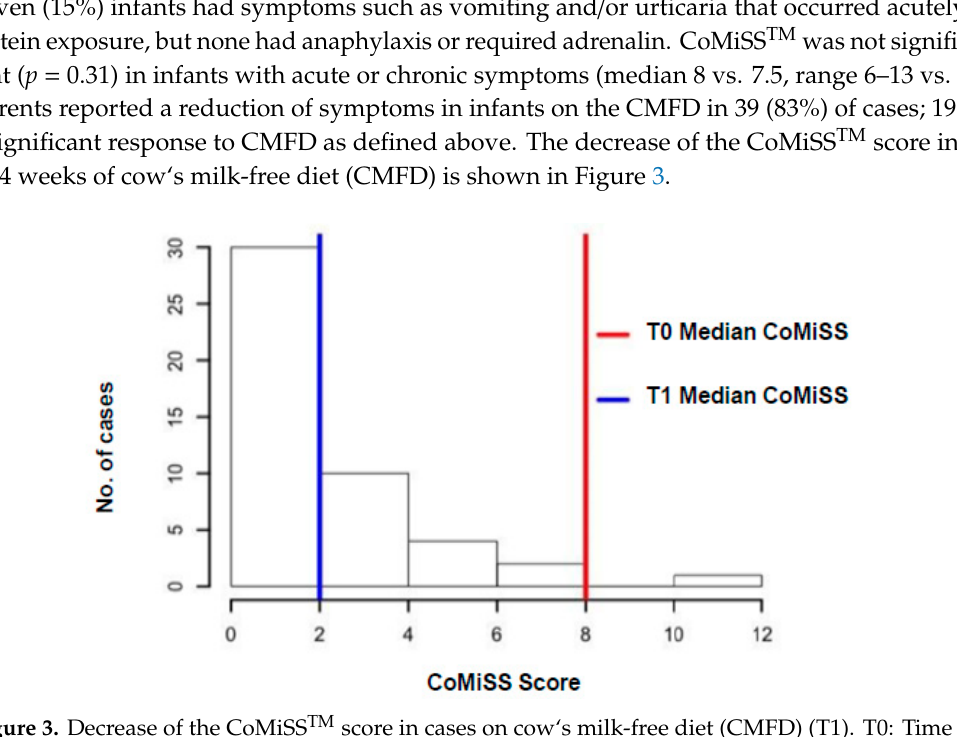
Figure 3. Decrease of the CoMiSS TM score in cases on cow‘s milk-free diet (CMFD) (T1). T0: Time 0 (first visit); T1: Time 1 (second visit after 2–4 weeks of cow‘s milk (CM) protein elimination diet). Di ff erences between responders and non-responders to CMFD are reported in Table 2. Table 2. Comparison between infants with response or no response to